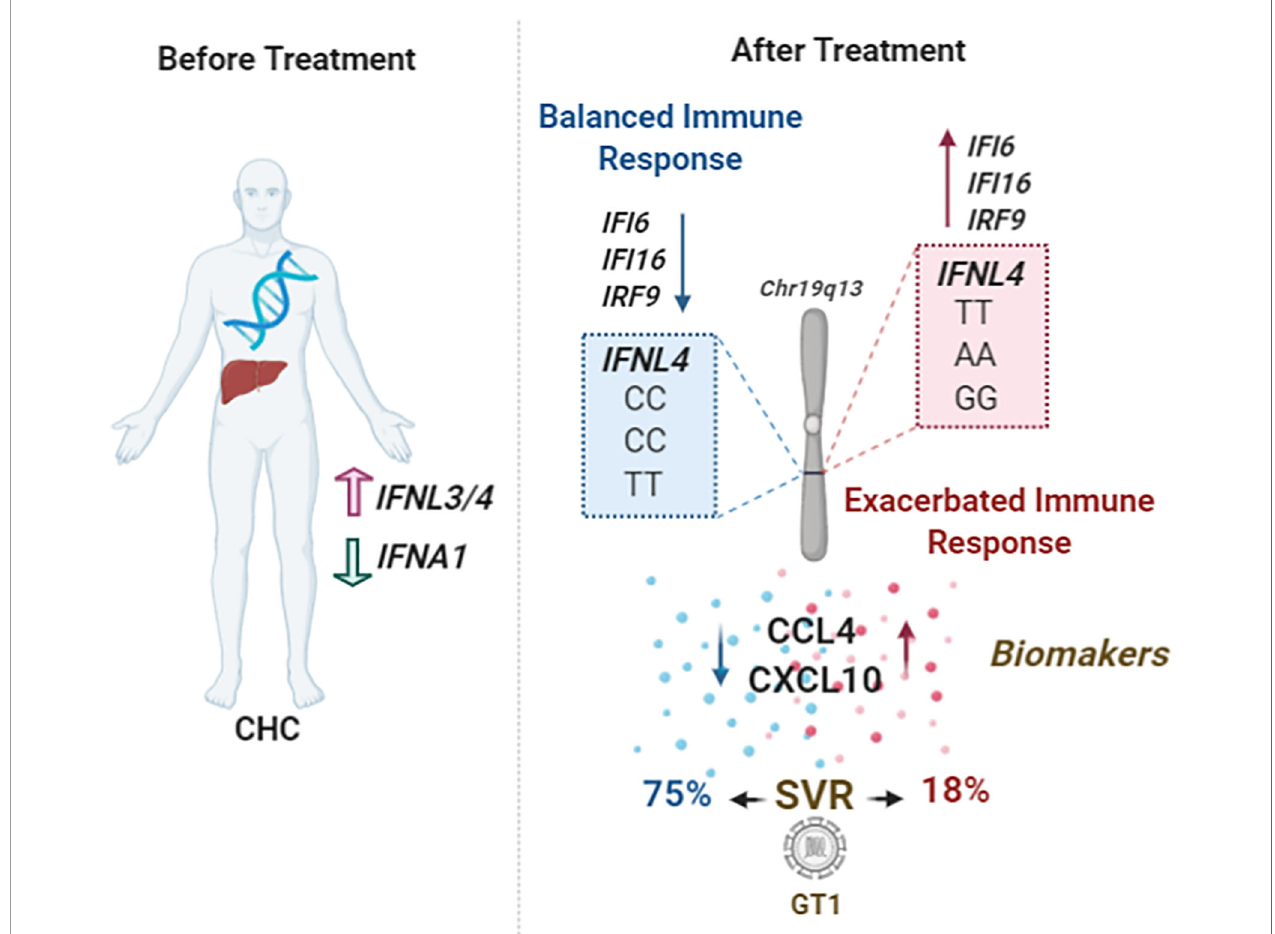
FIGURE 6 | Schematic model showing the main fi ndings of this study. Patients with CHC present high levels of cytokines before treatment and display an antagonistic effect between IFNL3/4 and IFNA1 expression levels. After treatment, patients with the genotypic combination of SNPs rs12979869-CC/rs8109886-CC/rs8099917-TT can induce a balanced immune response, presenting lower levels of ISGs, IFI6, IFI16, and IRF9, and low serum levels of the chemokines CCL4 and CXCL10. These patients can increase the SVR prediction, especially those infected with GT1, contrary to the patients with genotypes